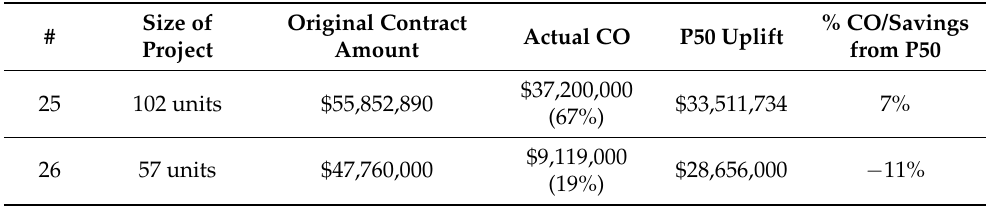
Table 4. Comparing the predictive robustness of the RCF